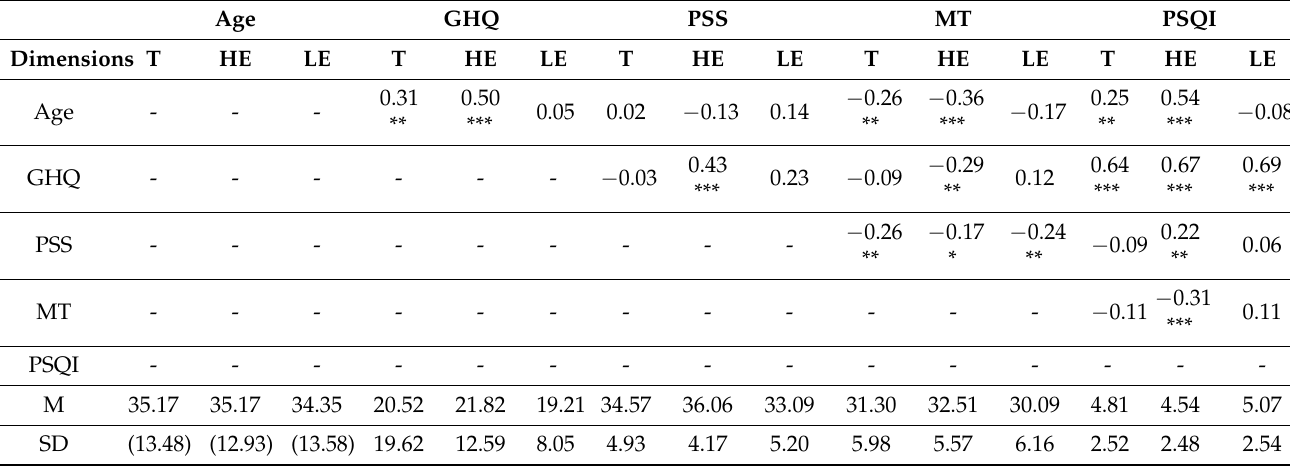
Table 2. Descriptive statistics and Pearson correlation coefficients between age, general health, perceived stress, mental toughness, and sleep disturbances for the whole group and separately for heavy and light